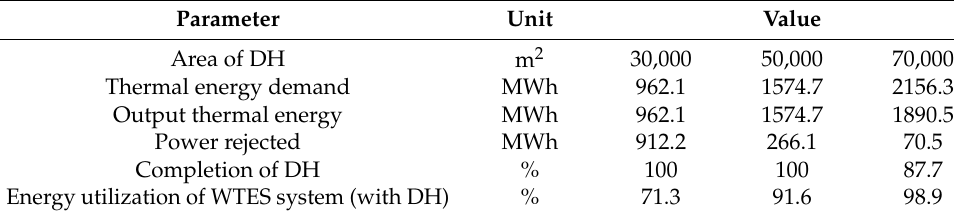
Table 5. Performance evolutions with different scales of